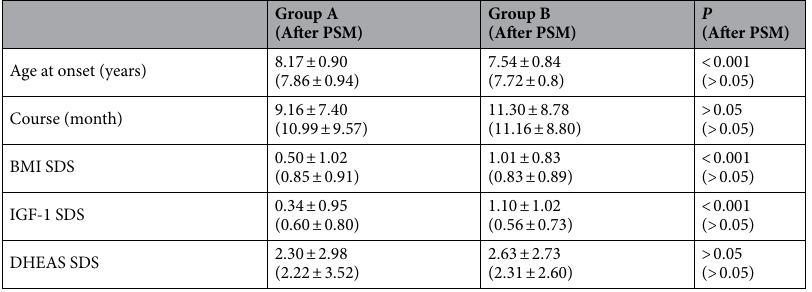
Table 1. Baseline characteristics of girls before and after PSM analysis. PSM propensity score matching, BMI SDS standard deviation score of the body mass index, IGF-1 SDS standard deviation score of the insulin-like growth factor-1, DHEAS SDS standard deviation score of dehydroepiandrosterone. Parentheses indicate after PSM.